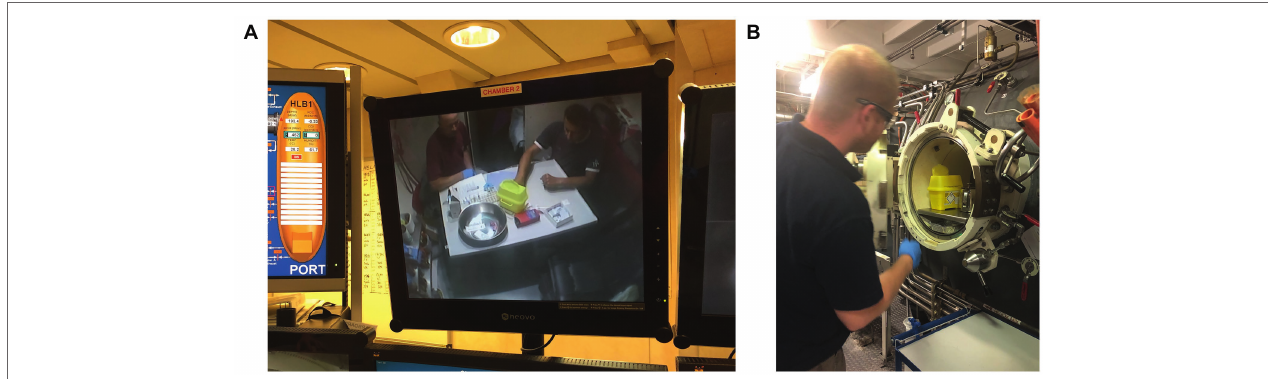
FIGURE 1 | (Panel A) Divers in saturation onboard the DSV Deep Arctic measuring Hb on a battery-operated HemoCue 201+ device (red box on the table in Chamber 2). Whereas the Hb device and unused consumables remained in the hyperbaric chamber for the duration of the saturation, waste from the procedure was transported out via a decompression lock (Panel B)